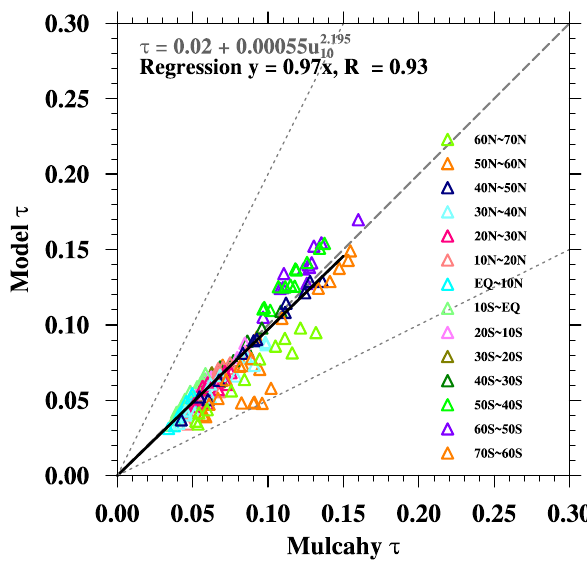
Fig. 10. Modeled optical depth model compared with calculated optical depth by Mulcahy et al. (2008) wind speed-optical depth relationship in 1994. The slope of the regression line and the cor- relation (R) are shown. The long dash line is the one-to-one line and the short dash lines are one-to-two and two-to-one lines. Each triangle is a monthly-mean of a 10 ◦ latitude region. Colors repre- sent the latitudes. The model used the CMS source function and a solubility factor of